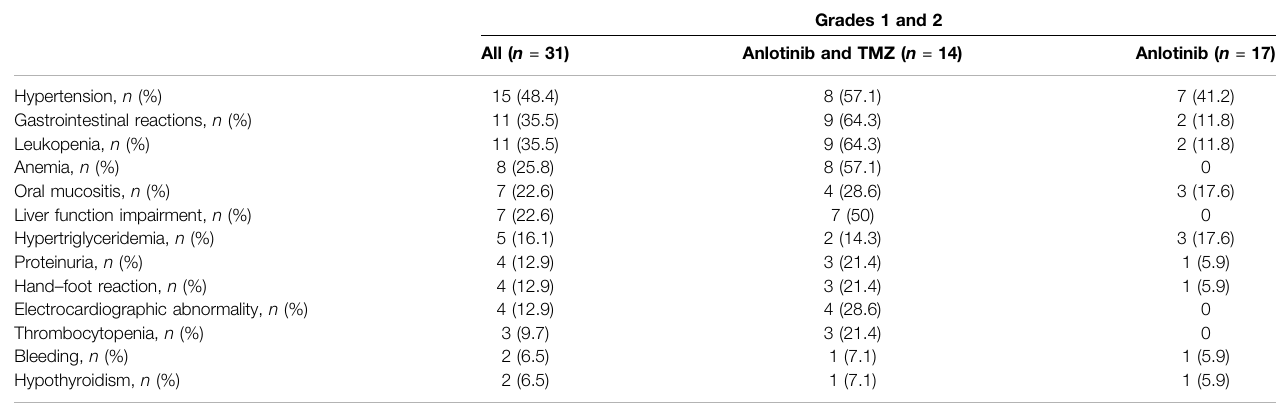
TABLE 3 | The most common treatment-related adverse